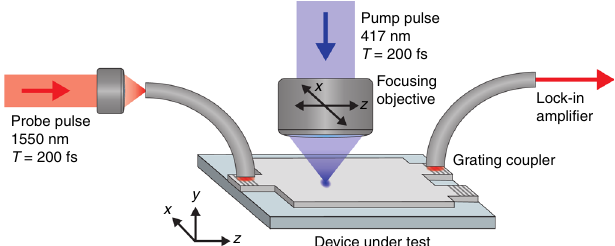
Fig. 6 Illustration of the experimental setup. Infrared probe pulses are grating-coupled into the waveguide, travel through the device and are then out-coupled by another grating. The transmitted light is collected by an optical fi ber and the transmission is recorded by an InGaAs photodetector connected to a lock-in ampli fi er. The pump pulses are incident perpendicular to the device ’ s surface, and the delay time between the two pulses is controlled via a variable time delay stage. The pump focusing objective is mounted to a 3D piezo stage which allows the pump spot to be focused and scanned over the